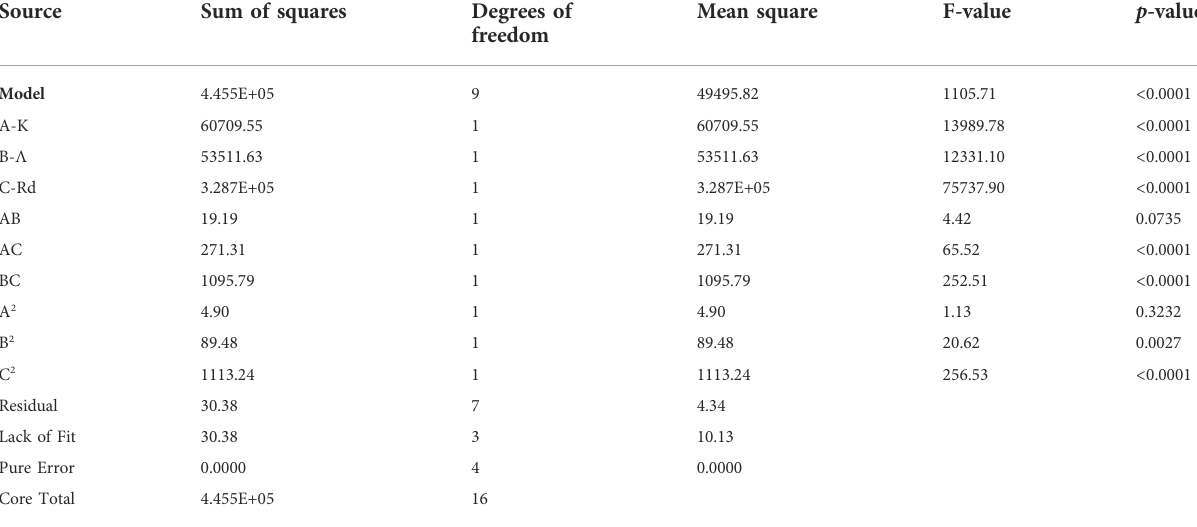
TABLE 4 ANOVA for response surface quadratic model for Entropy generation number.